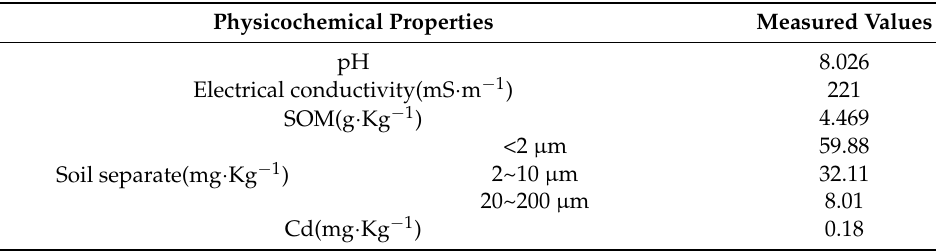
Table 9. The physicochemical properties of soil for pot